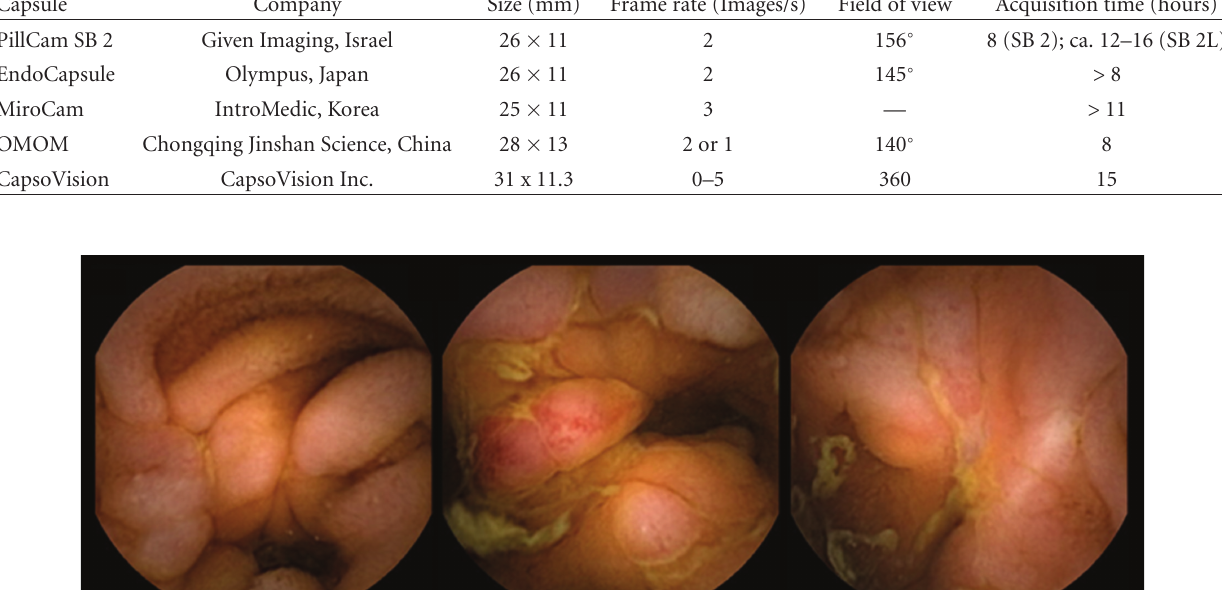
Figure 1: Crohn’s disease of the small bowel in capsule endoscopy: multiple small ulcerations all over the ileum and jejunum, scarring alterations of the small